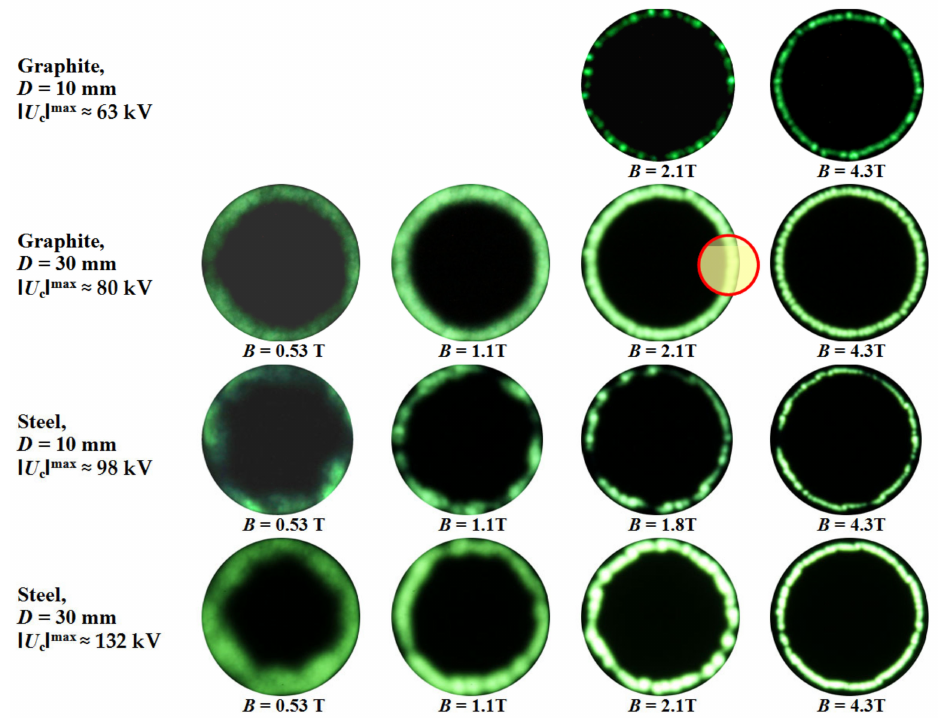
Figure 5. Autographs of magnetized tubular RAE beams obtained in atmospheric air at various values of accelerating gap D (10 and 30 mm), cathode voltages (63–132 kV), and magnetic fields (0.53–4.3 T) for graphite and steel cathodes having a diameter of 22 mm and emitting edge of ≈ 0.1 mm thick. The red circle shows the position of a fast-response current probe collector. Diameter of all photographs is 25